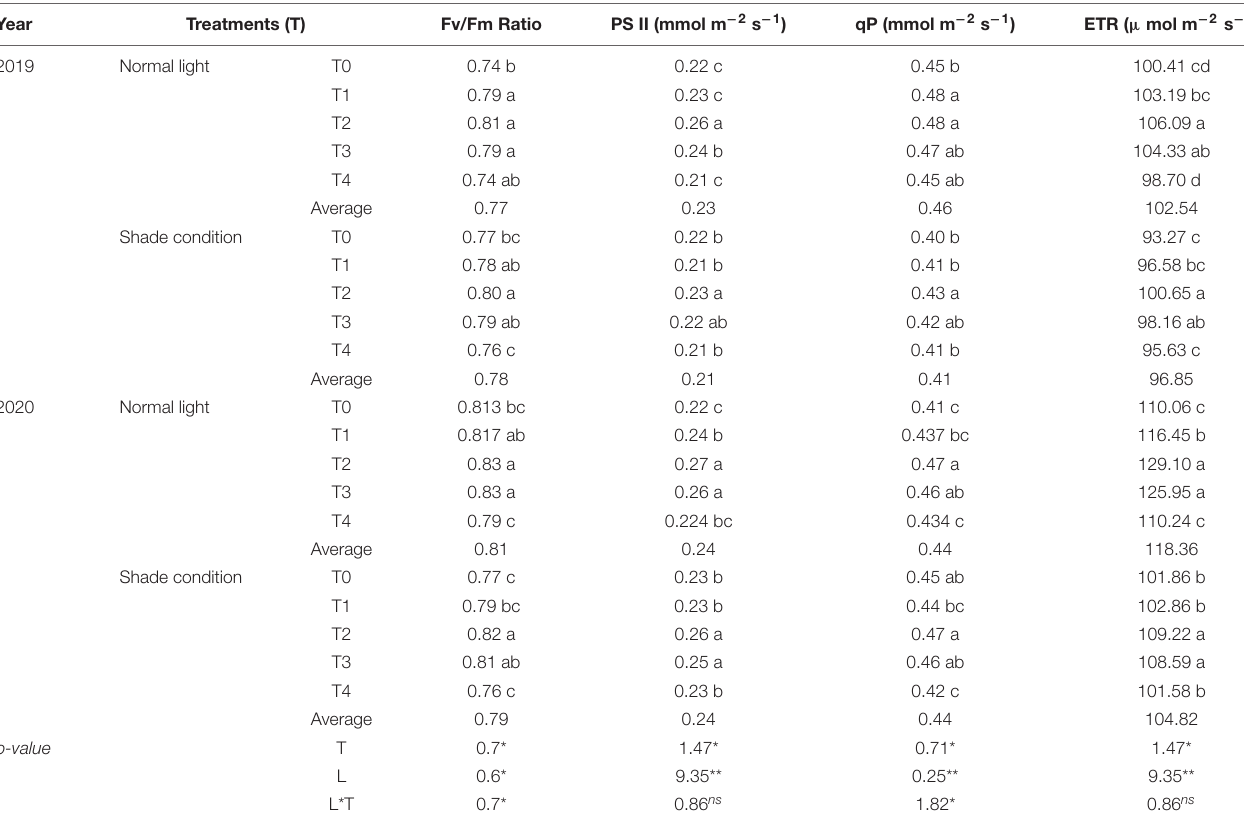
TABLE 3 | Effect of NH 4 + /NO 3 − on the photochemical efficiency under various light conditions.